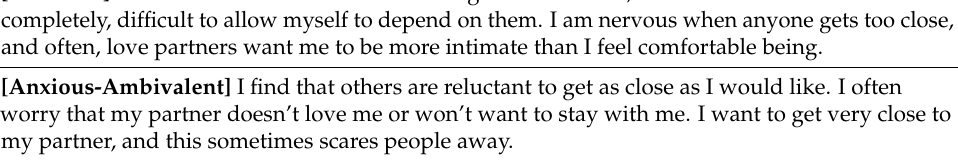
Table 1. Hazan and Shaver’s secure, avoidant, anxious/ambivalent